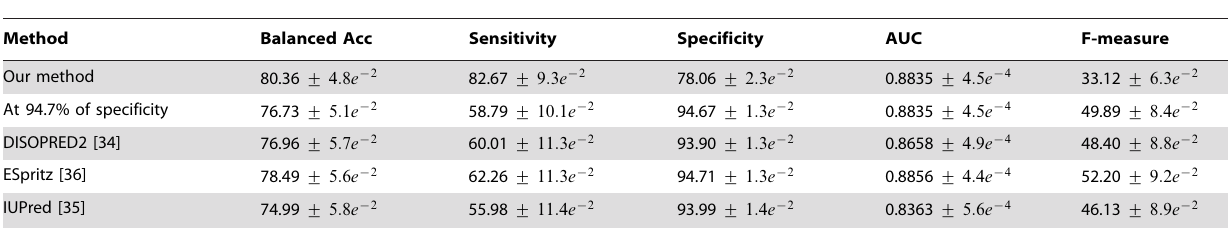
Table 7. Evaluation on the PDB30